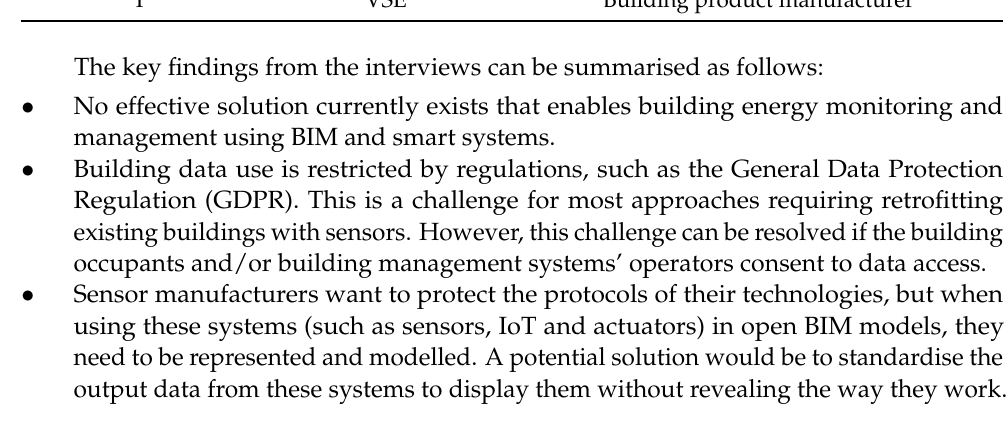
Table 1. Companies interviewed during ENERJ-MEETING 2020 event in Paris, France.